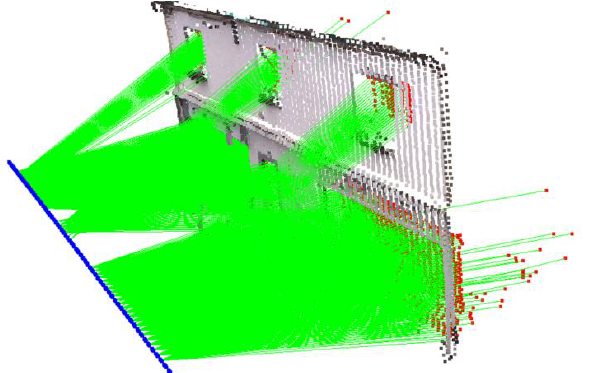
Figure 5: Laser rays that intersect plane and whose laser points lie behind the plane. Blue points show the sensor positions.